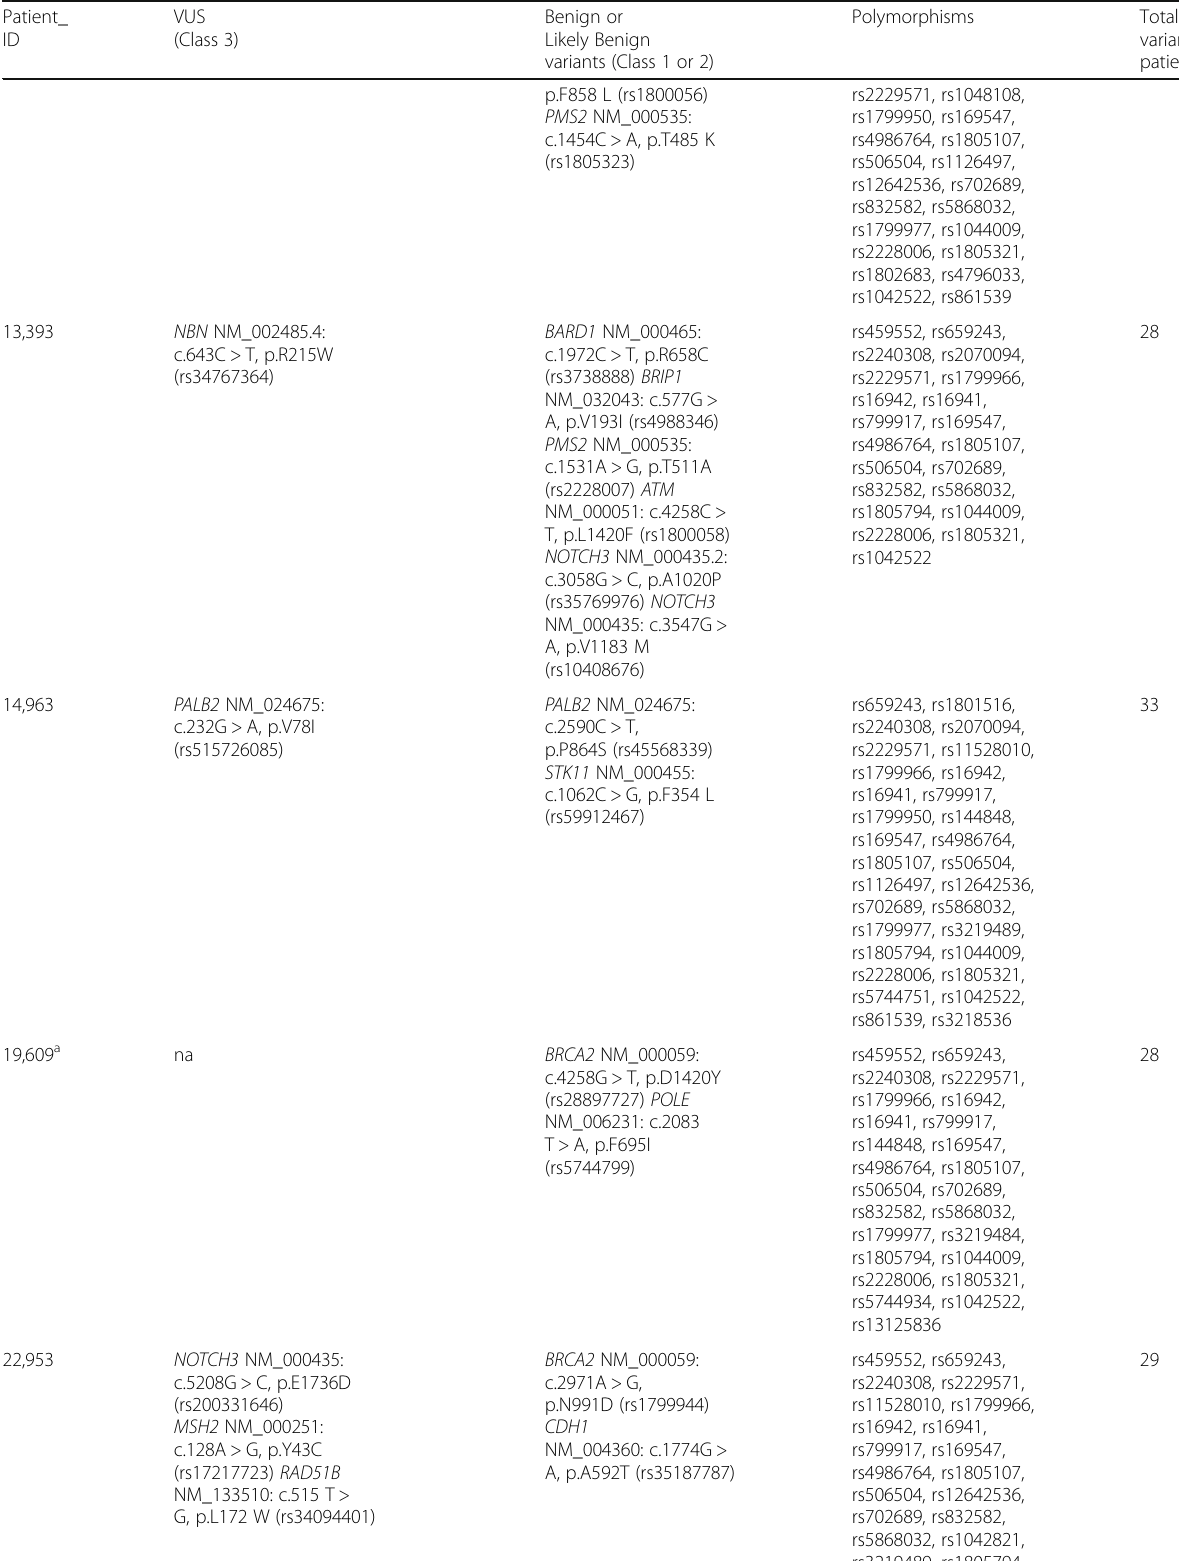
Table 2 Characterization of germline variants found among Norwegian familial CRC individuals